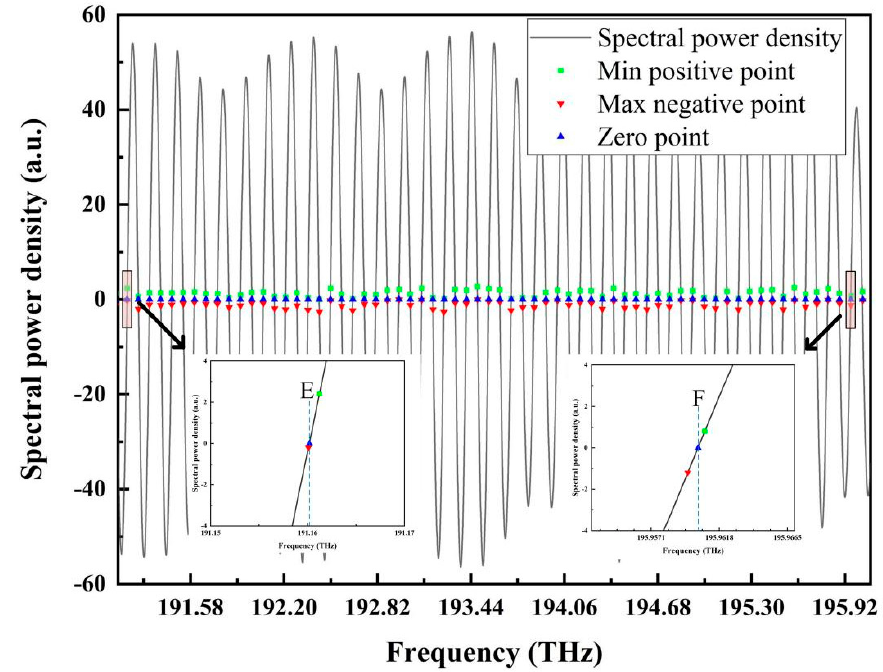
Figure 11. The reflection spectrum in the optical frequency domain of a fiber-optic FP sensor with a cavity length of 999.482 μ m.